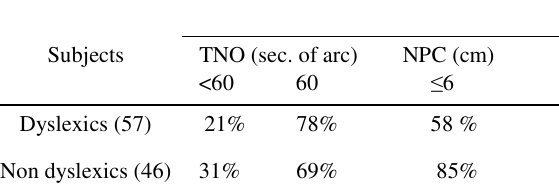
Table 1 Percentages of dyslexic and non-dyslexic children with stereoacuity (measured with the TNO test) better or equal to 60 seconds of arc and percentages of children with near point of convergence (NPC) below 6 cm